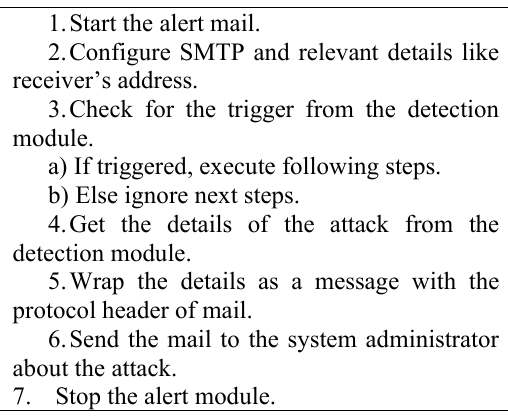
Fig.6 Algorithm for alert module of the proposed